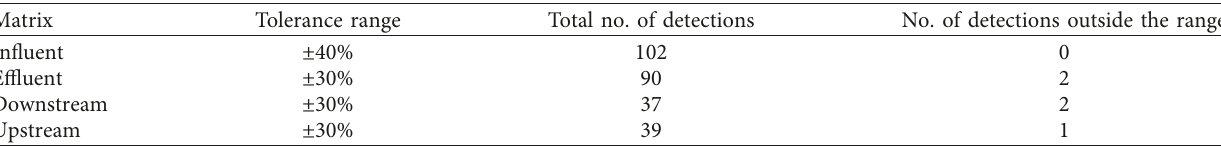
Table 6: Results of the application of the ion ratio criterion in real wastewater and surface water samples.